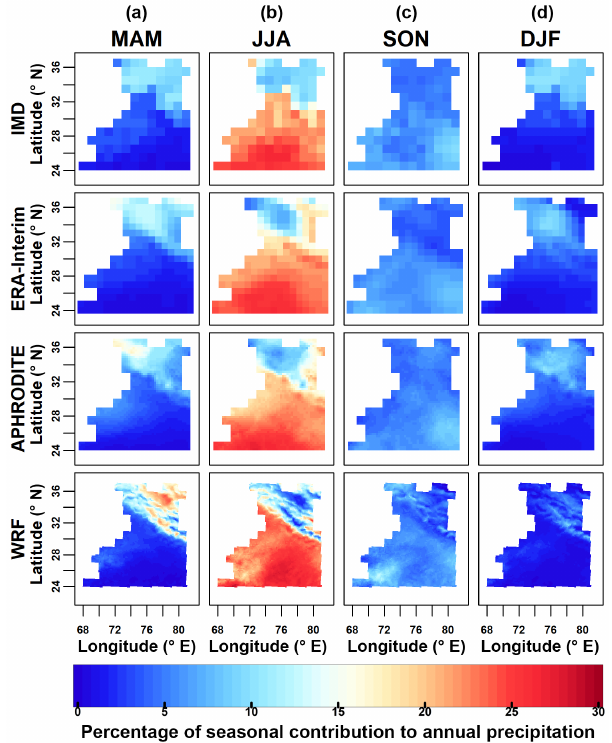
Figure 5. Seasonal contributions (in %) to annual precipitation. (a) spring (MAM), (b) summer (JJA), (c) autumn (SON) and (d) winter (DJF). From bottom to top: WRF regional climate model, APHRODITE gridded observations, ERA-Interim reanalysis and IMD gridded